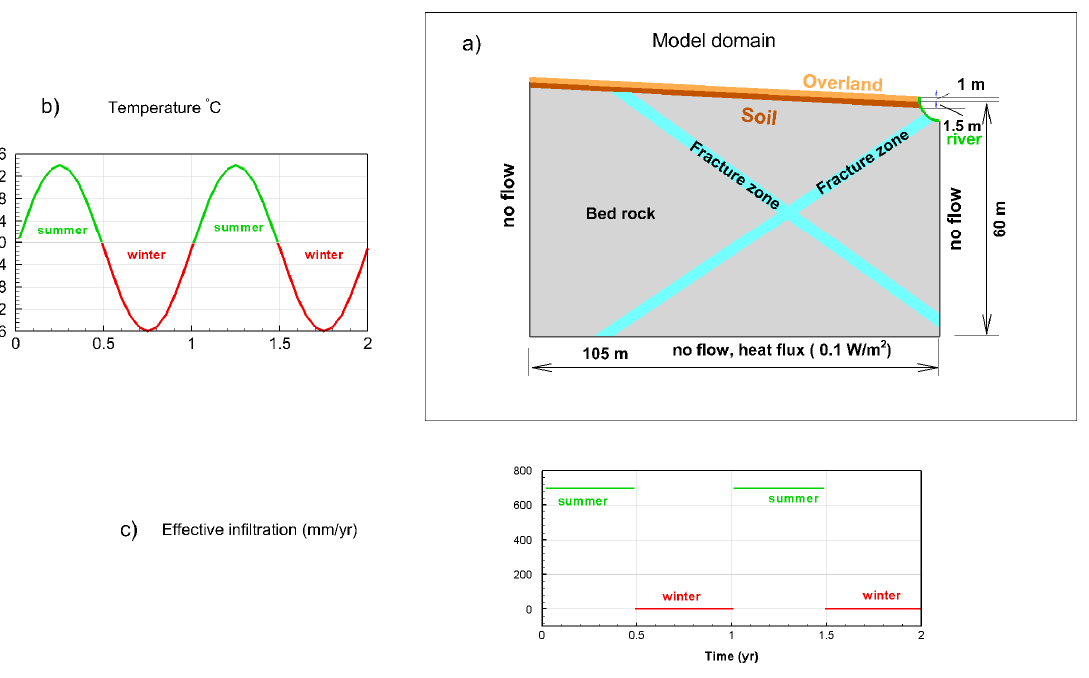
Figure 2. ( a ) Simulation domain; ( b ) boundary conditions for temperature; and ( c ) boundary conditions for effective infiltration (precipitation minus evapotranspiration).